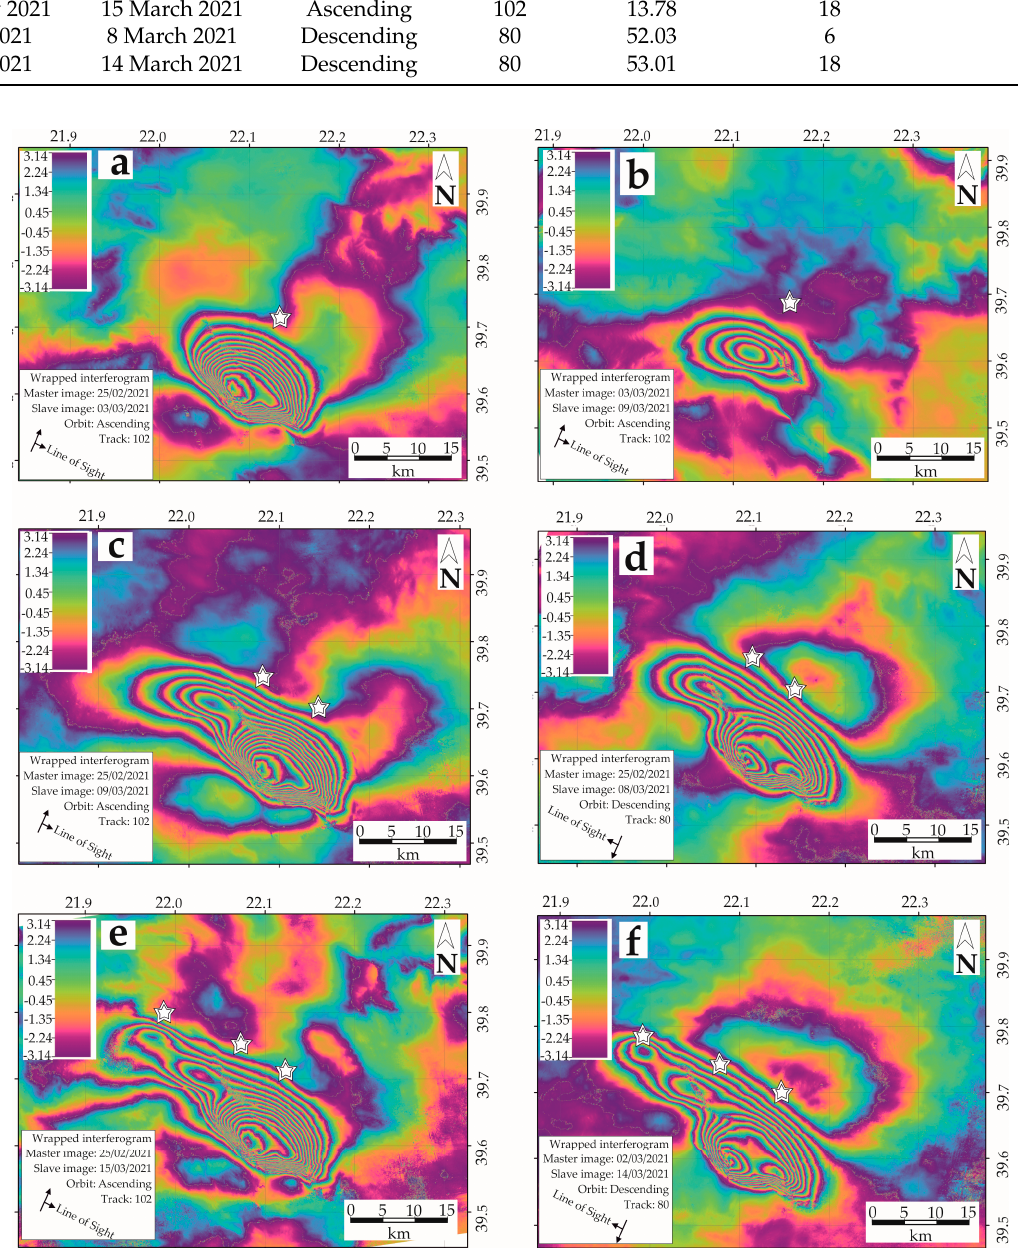
Figure 4. Sentinel-1 interferograms. ( a ) Sentinel-1 ascending interferogram capturing deformation of 3 March earthquake. ( b ) Sentinel-1 ascending interferogram capturing deformation of the 4 Marchearthquake. ( c ) Sentinel-1 ascending interferogram capturing deformation of 3 and 4 March earthquakes. ( d ) Sentinel-1 descending interferogram capturing deformation of 3 and 4 March earthquakes. ( e ) Sentinel-1 ascending interferogram capturing deformation of 3, 4, and 12 March earthquakes. ( f ) Sentinel-1 descending interferogram capturing deformation of 3, 4, and 12 March earthquakes.